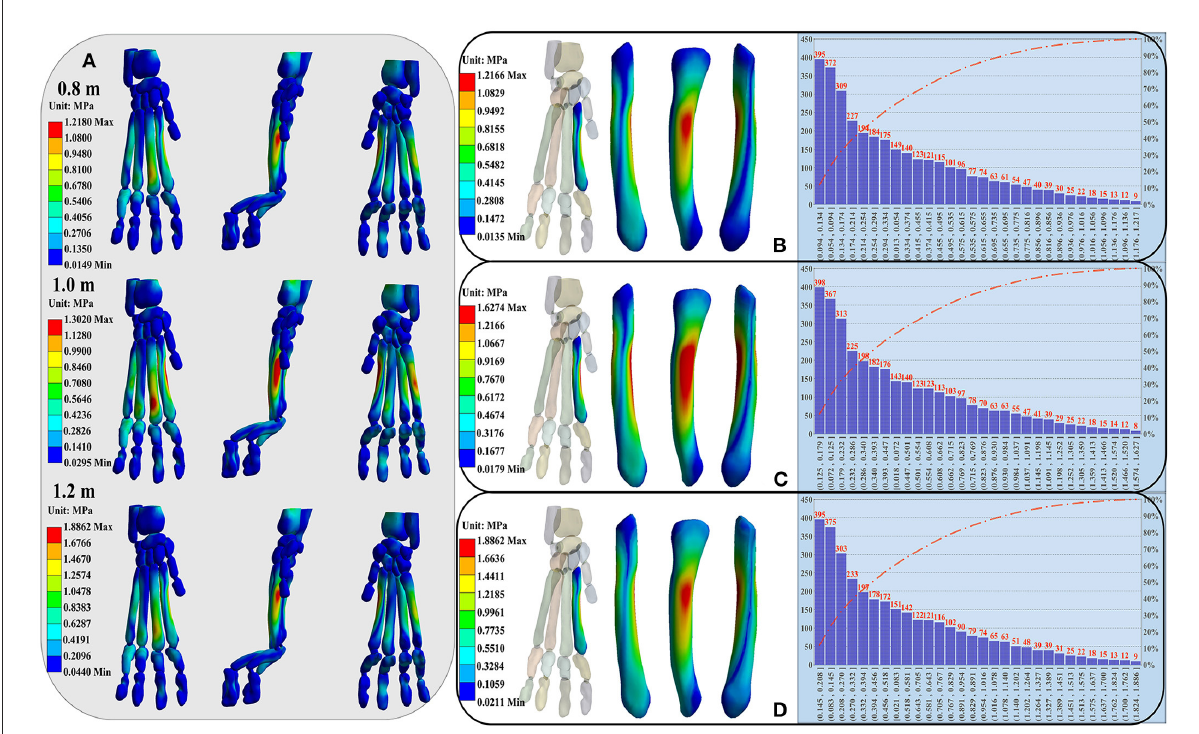
FIGURE4 (A) Illustration of the right forelimb paw stress distribution of the cat landing from different heights. From left to right are front, side and back views of the overall stress distribution. (B–D) Display the detailed stress distribution heatmap (left side) and Pareto distribution (right side) results of stress values at all nodes of MP2. From left to right are front view, side view and back view of the MP2. The stress distribution from top to bottom corresponds to the landing heights of 0.8, 1.0, and